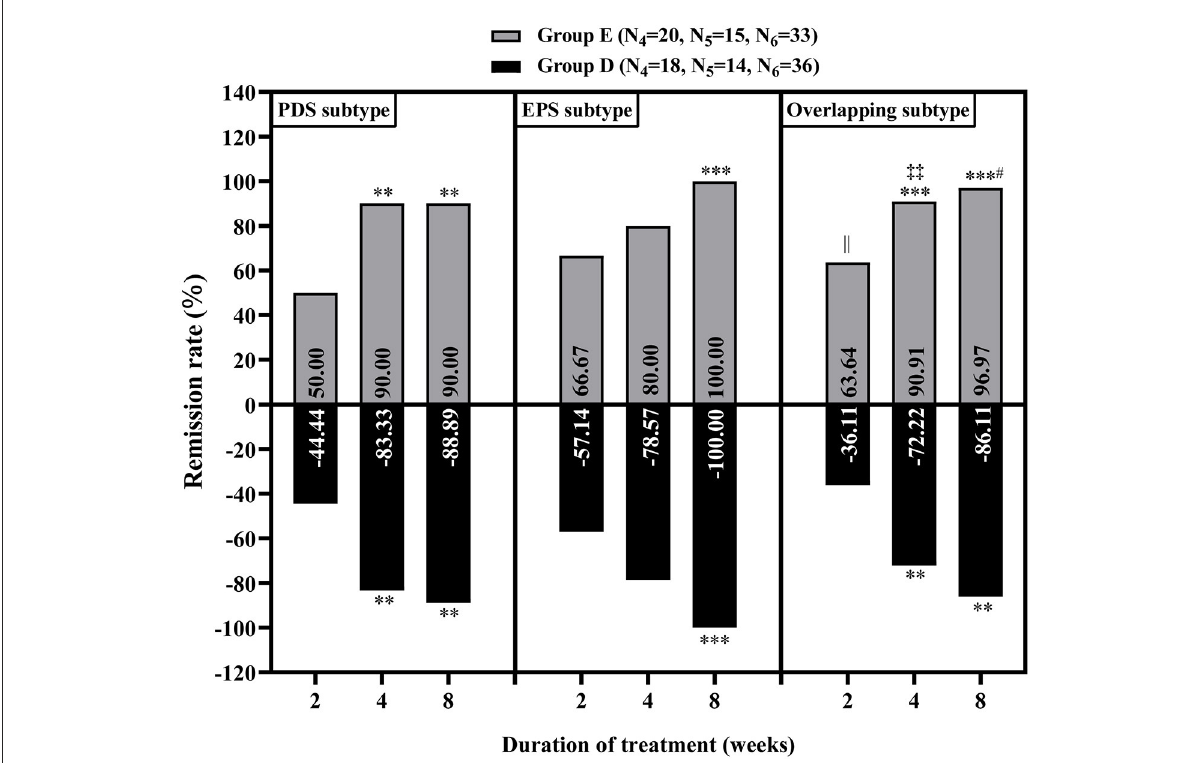
FIGURE4 Relief of overall gastrointestinal symptoms in the patients with functional dyspepsia of different subtypes without mood disorders at 2, 4 and 8 weeks of treatment. Group D: nizatidine, Group E: rabeprazole. N4, N5 and N6 correspond to the number of patients with postprandial distress syndrome (PDS), epigastric pain syndrome (EPS) and overlapping subtype (one or two symptoms of PDS and EPS), respectively. ** P < 0.01, *** P < 0.001: vs. 2 weeks of treatment in the same group; # P < 0.05: vs. 4 weeks of treatment in the same group; k P < 0.05: group E vs. group D at 2 weeks of treatment; ‡‡ P < 0.05: group E vs. group D at 4 weeks of